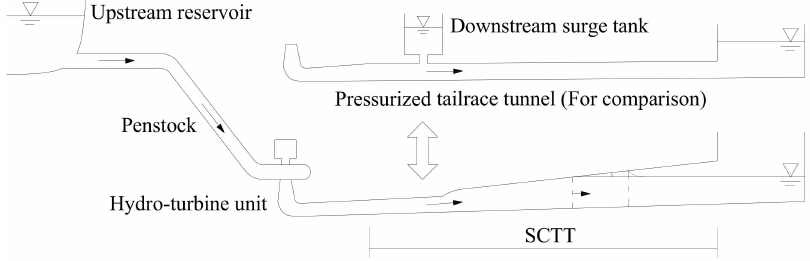
Figure 1. Layout of a hydropower plant with a sloping ceiling tailrace tunnel